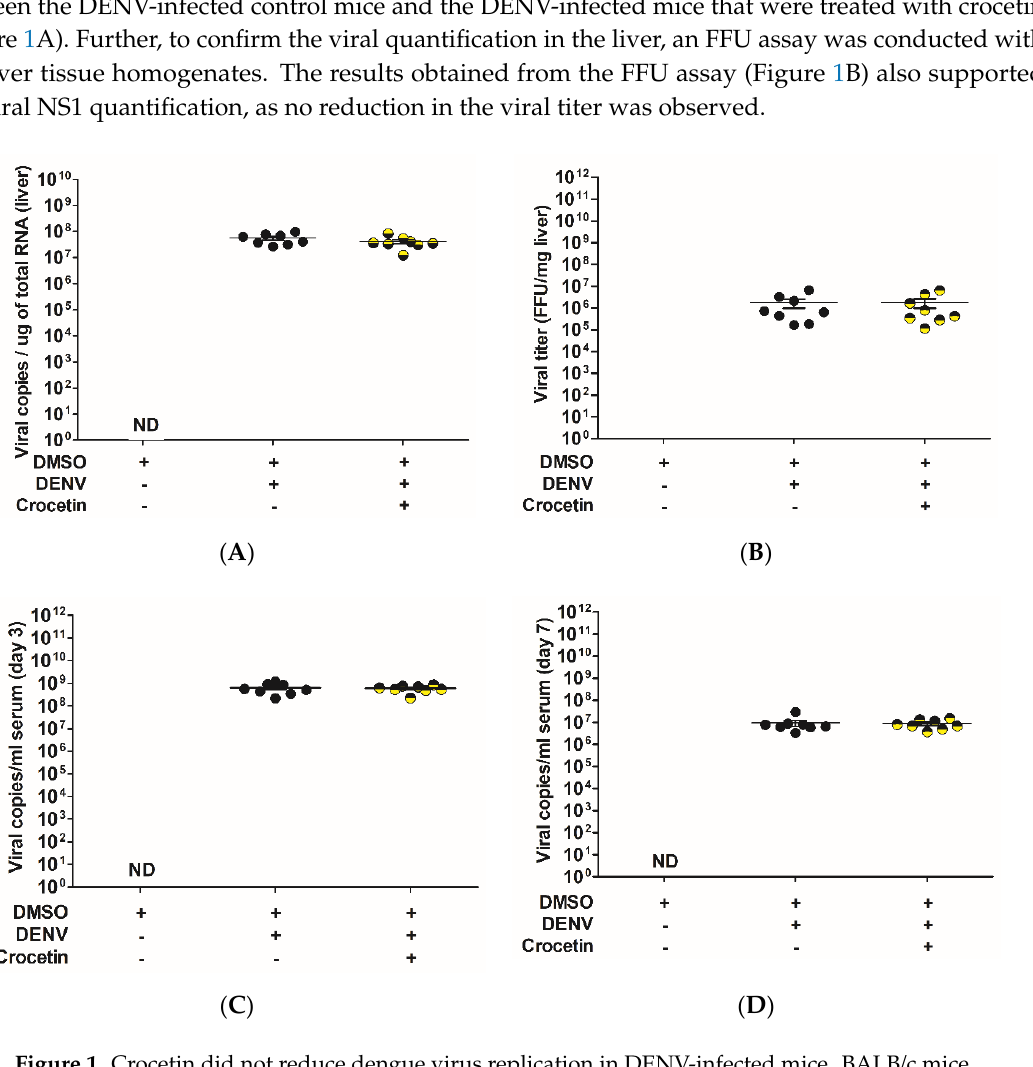
Figure 1. Crocetin did not reduce dengue virus replication in DENV-infected mice. BALB/c mice were infected with DENV-2 (4 × 10 5 FFU/mL) and then treated with crocetin (50 mg/kg) dissolved in 2% DMSO. DENV-infected 2% DMSO-treated and mock-infected 2% DMSO-treated groups of mice were